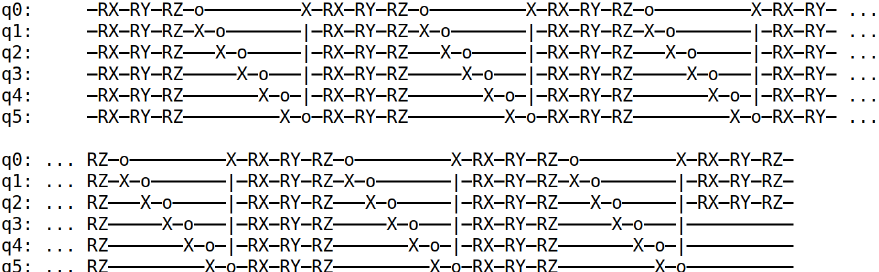
Figure 5. Circuit representation of the quantum encoder used for anomaly detection of handwritten digits. The encoder circuit is composed of six qubits and six layers. At the end of the quantum circuit, the first three qubits are measured in order to compress information on the three remaining qubits. The loss function is computed as the sum of the probabilities of having any of the measured qubits in the ground